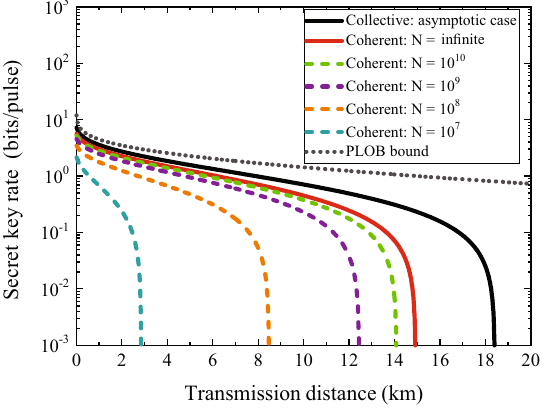
Figure 2. Secret key rates of the CV-SDI QKD protocol. The protocol is under symmetric configuration with τ τ = = T where T is the total transmissivity of the channel. We consider the protocol with perfect A B reconciliation efficiency β = 1 and ideal modulation variance = V 10 5 . We also set the excess noise as ξ = 0.001 in each channel and the overall security parameter is smaller than 10 − 20 . The gray dot line is the PLOB bound 45 and the black solid line is the key rate under collective attacks. The red solid line is the key rate under coherent attacks with infinite exchanged signals. The four dashed lines, from top to bottom, are the secret key rates under coherent attacks, with the block lengths from 10 10 to 10 7 .